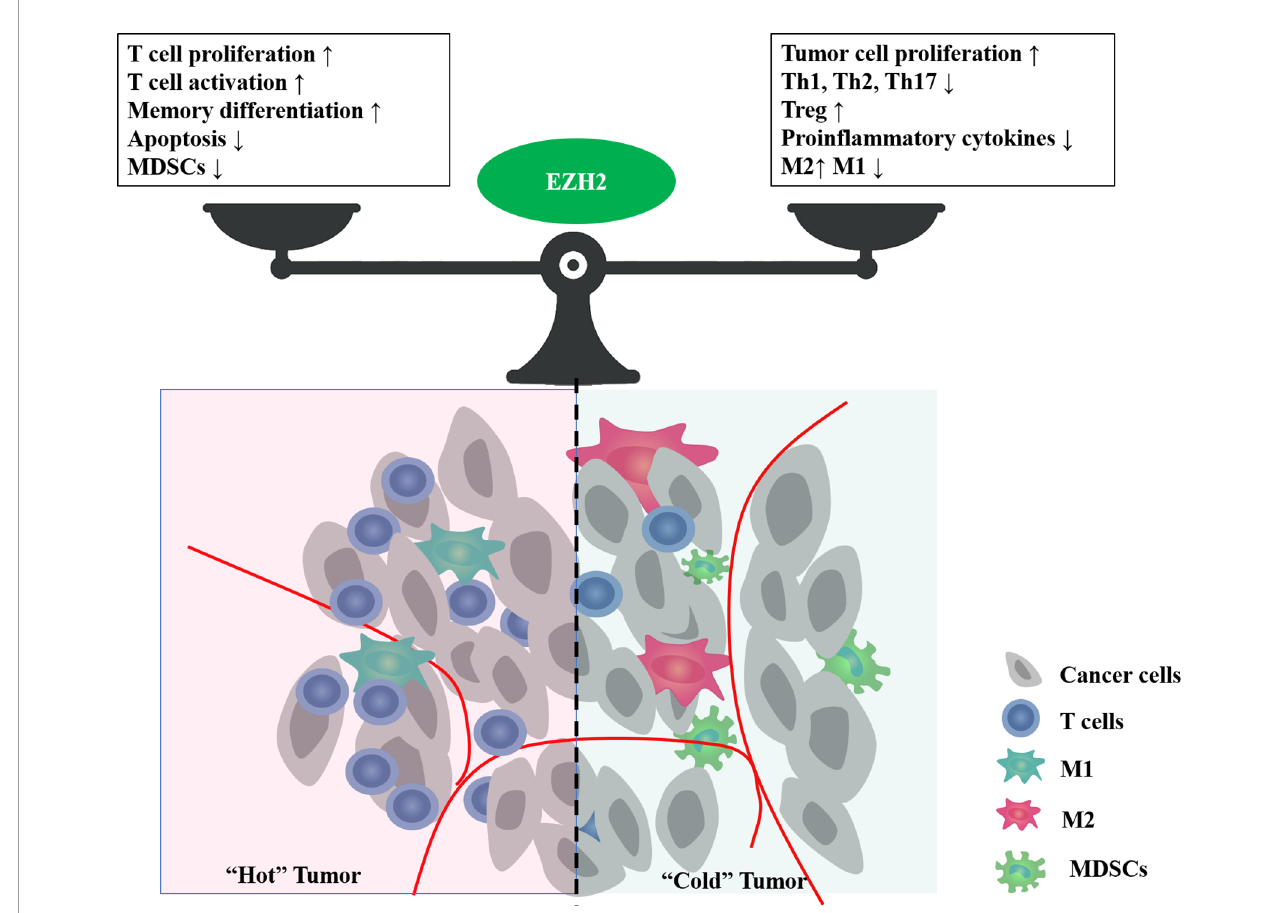
FIGURE 3 | The bidirectional effect of EZH2 on tumor immune microenvironment. EZH2 can regulate multiple cellular components in the tumor microenvironment, such as cancer cells, T cells, macrophages, and myeloid-derived suppressor cells (MDSCs). Major phenotypes associated with EZH2 function in balancing the tumor immune